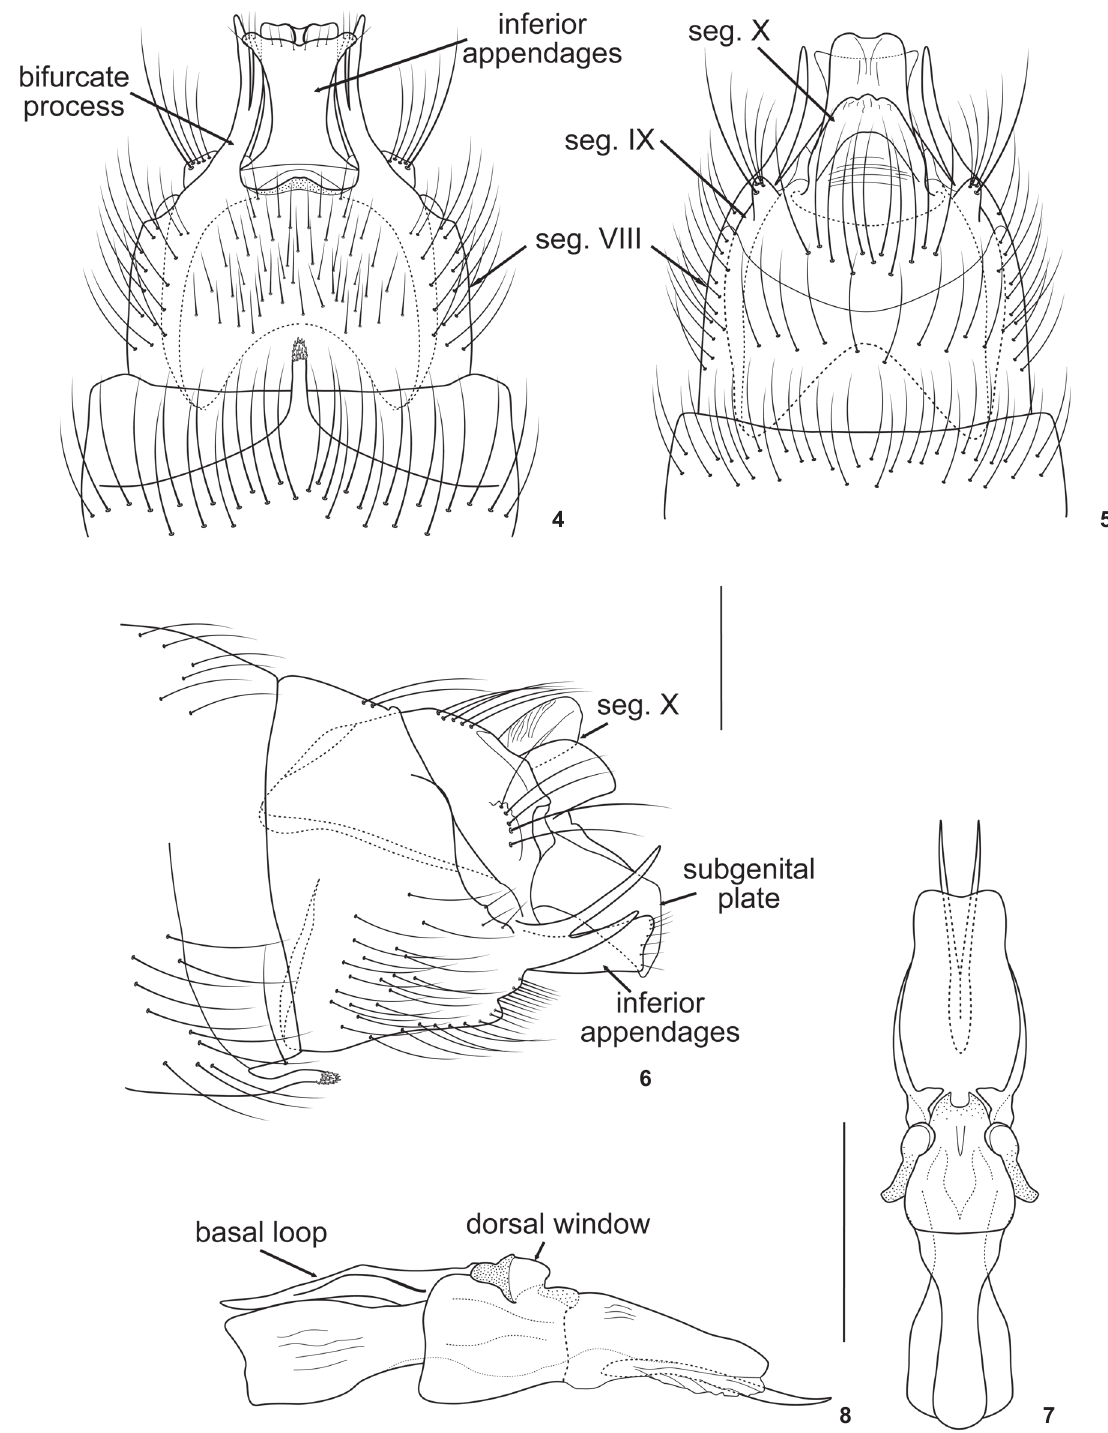
Figures 4-8. Costatrichia nelsonferreirai sp. nov. , male genitalia: (4) ventral view; (5) dorsal view; (6) lateral view; (7) phallus, dorsal view; (8) phallus, lateral view. Scale bar = 0.1